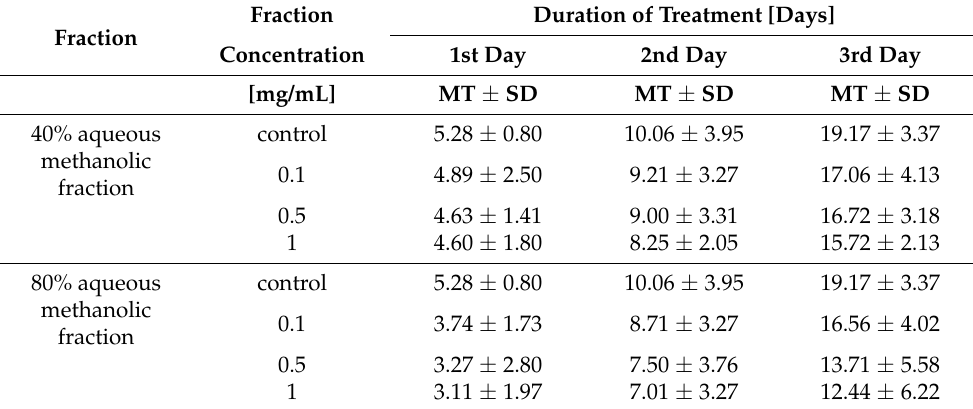
Table 5. The effect of the 40% and 80% aqueous methanolic fractions of the extract from the flowering herb of micropropagated Lychnis flos-cuculi , at different concentrations, on Acanthamoeba trophozoite inhibition during three-day treatment.